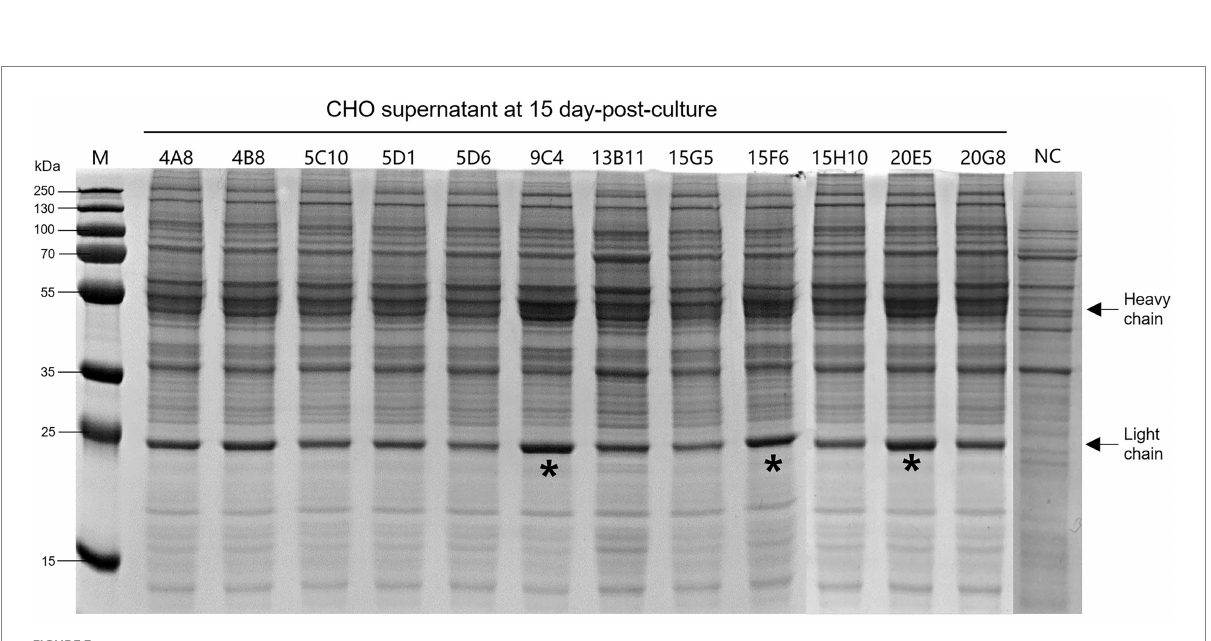
FIGURE 3 Expression levels of the 12 selected CHO clones after 15-day incubation. Black arrows indicated the heavy and light chains. The “*” indicated three clones with higher expression levels. NC, normal cell of